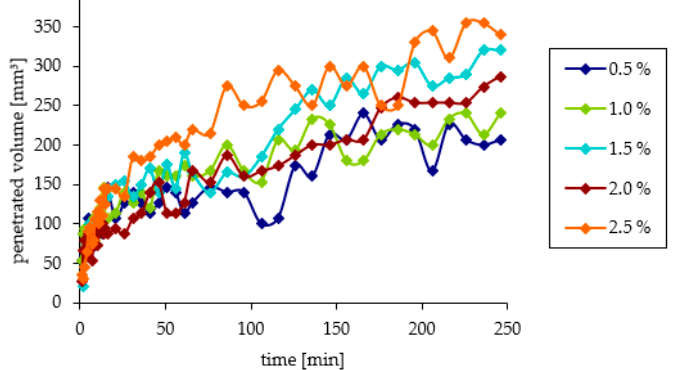
Figure 4. The course of changes in the penetrated volume of the model skin sebum under the influence of AMPD solutions with various concentrations within 240 min.